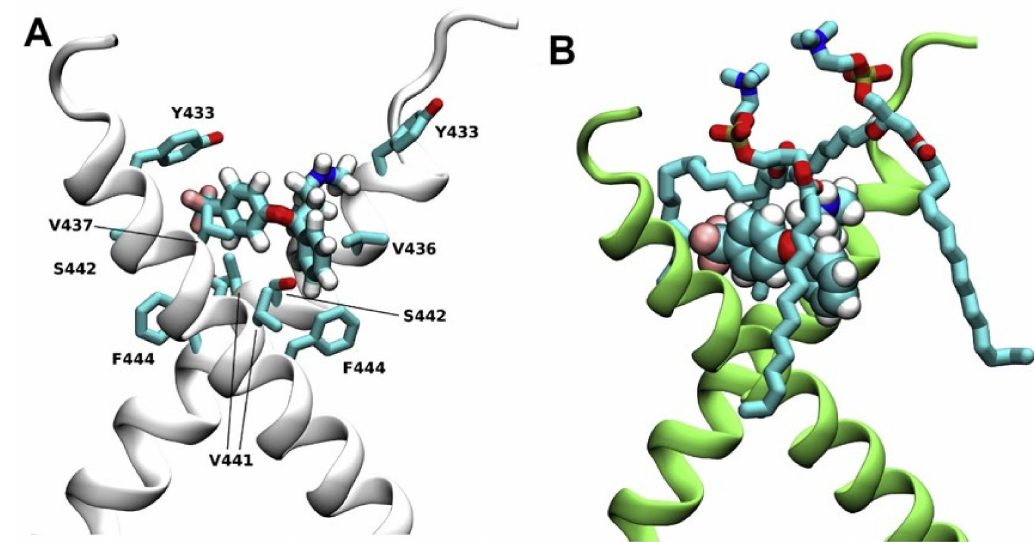
Figure 23. Transmembrane domain of TRKB dimer formed by the crisscross oriented helices forms a pocket for antidepres- sant binding. ( A ) Antidepressant fluoxetine is embedded in the crevice between the two helices of the TRKB transmembrane domain. Protein backbone shown in white cartoon and protein residues and fluoxetine in licorice representation. ( B ) Binding site for antidepressants at the outer opening of the crossed dimer is stabilized by the phospholipids. Protein backbone shown as green cartoon, the phospholipids in licorice and fluoxetine in vdW representations.